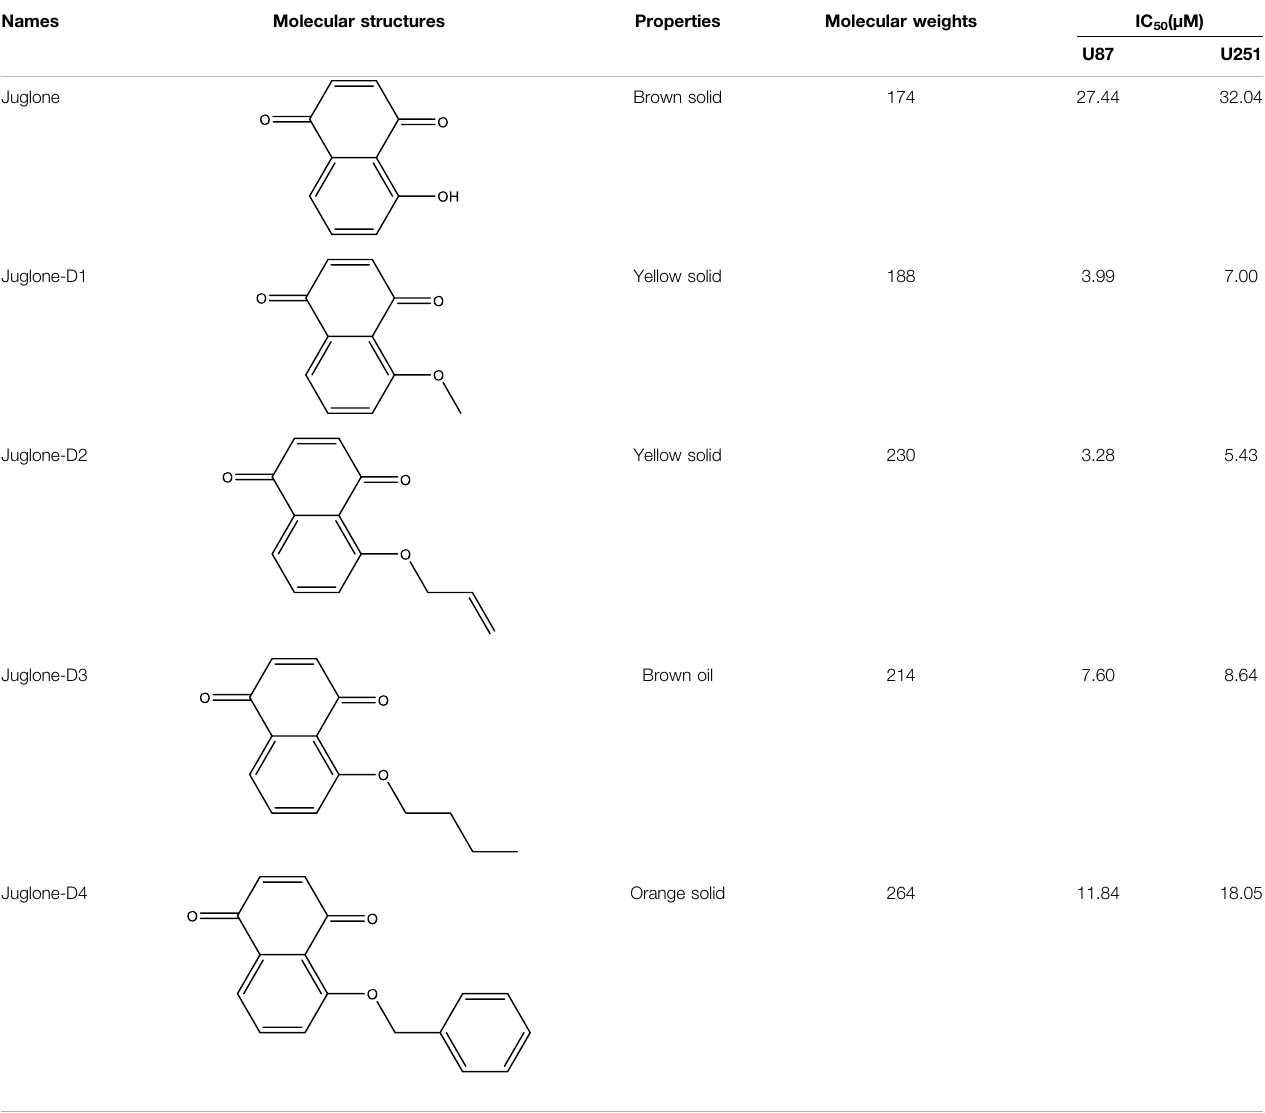
TABLE 1 | Brief summary of juglone and